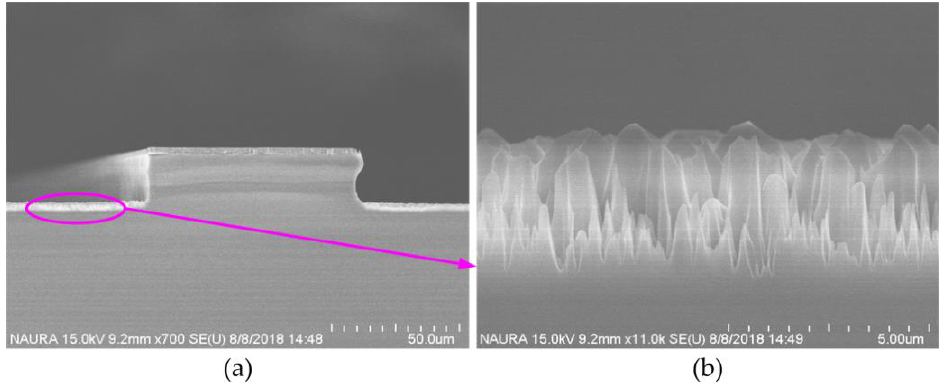
Figure 5. ( a ) Scanning Electron Microscope (SEM) picture of the rough etching bottom; ( b ) SEM picture of the enlarged partial bottom.